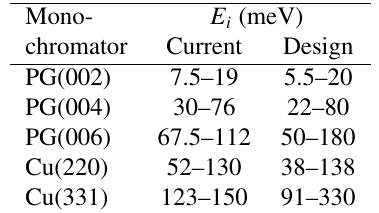
Table 2. Incoming neutron energies for the di ff erent monochromators on